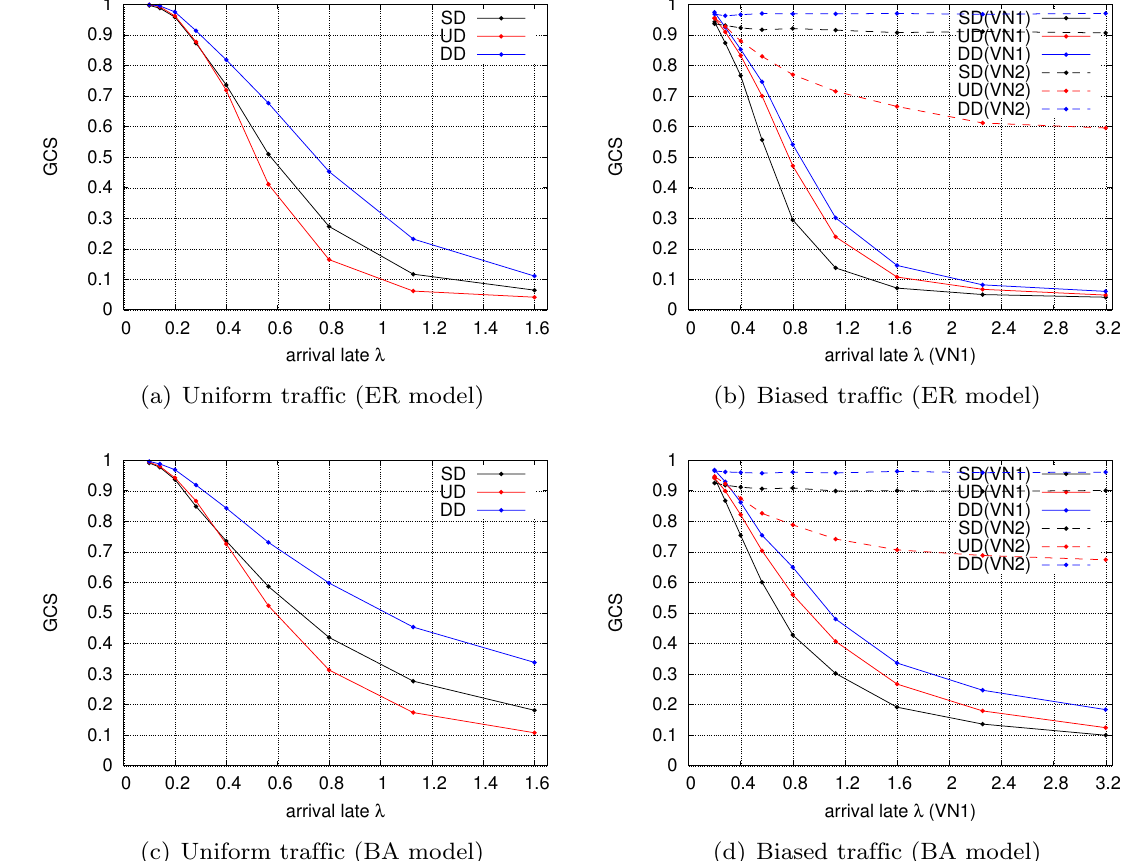
Figure 4. Variation of giant component size (GCS) with arrival rate λ . The vertical axis represents the GCS: 1 indicates that all the nodes on a VN are connected, whereas 0 indicates that they are completely disconnected. The solid lines in ( a , c ) correspond to the average GCS of the two VNs, whereas the GCS for each VN is plotted separately in ( b , d ). The horizontal axis represents the arrival rate λ . In ( b , d ), note that λ is changed on VN1 but fixed on